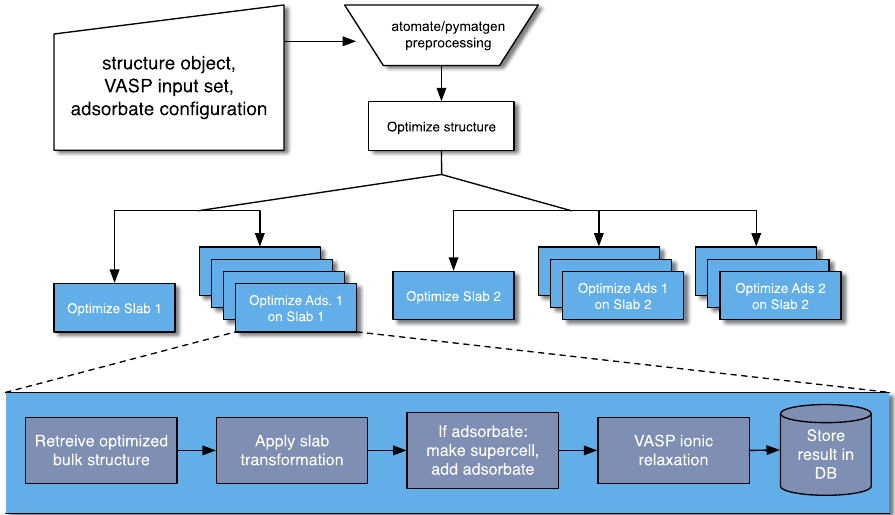
Fig. 3 Adsorption site selection for the Ni (111) slab, in which a periodic slab shown in ( a ) has its surface sites selected to generate a Delaunay triangulation network ( b ), with which adsorption sites are placed at face edges, centers, and vertices ( c ) and fi ltered such that symmetrically equivalent and very close sites are removed to yield a minimal set of distinct adsorption sites ( d )